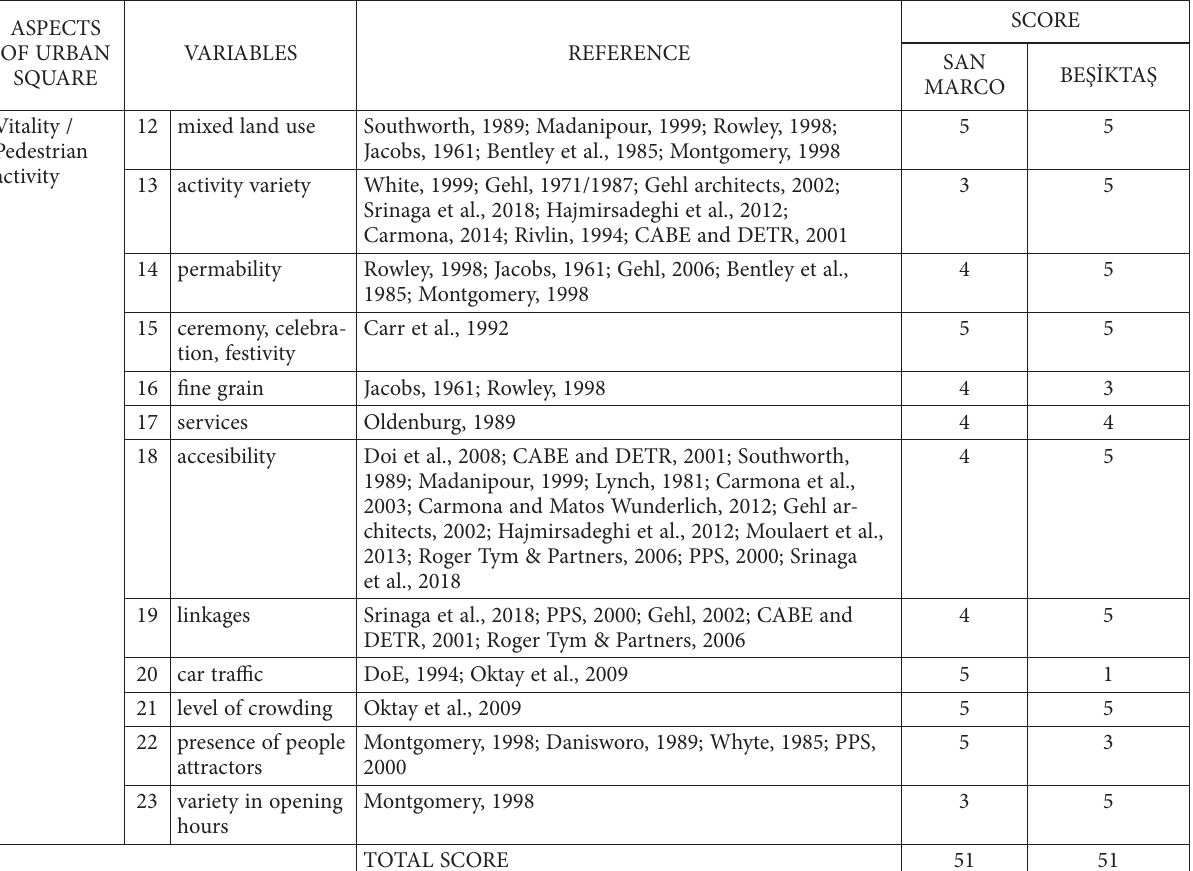
Table 2. Vitality / Pedestrian activity quality